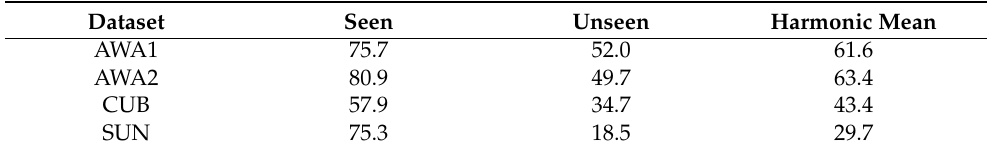
Table 4. Results of Generalized Zero-Shot setting (GZSL) that are calculated based on per-class average using seen classes, unseen classes, and harmonic